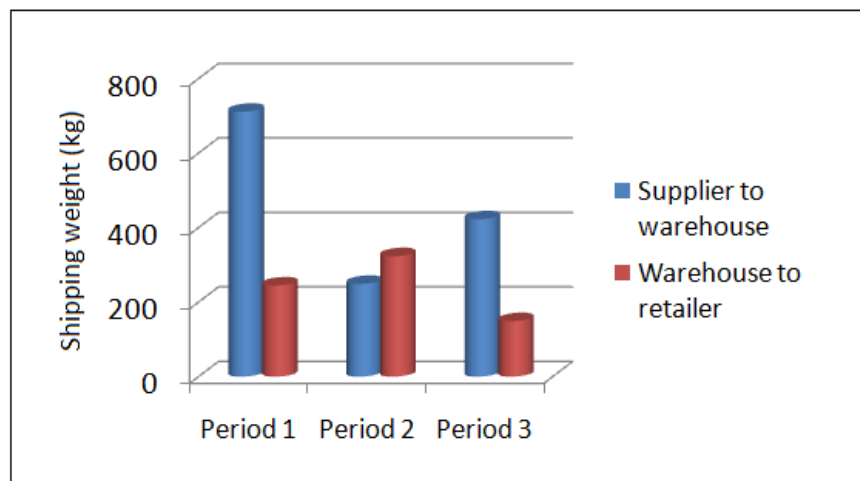
Figure 3. Shipping quantity for the periods 1, 2 and 3.